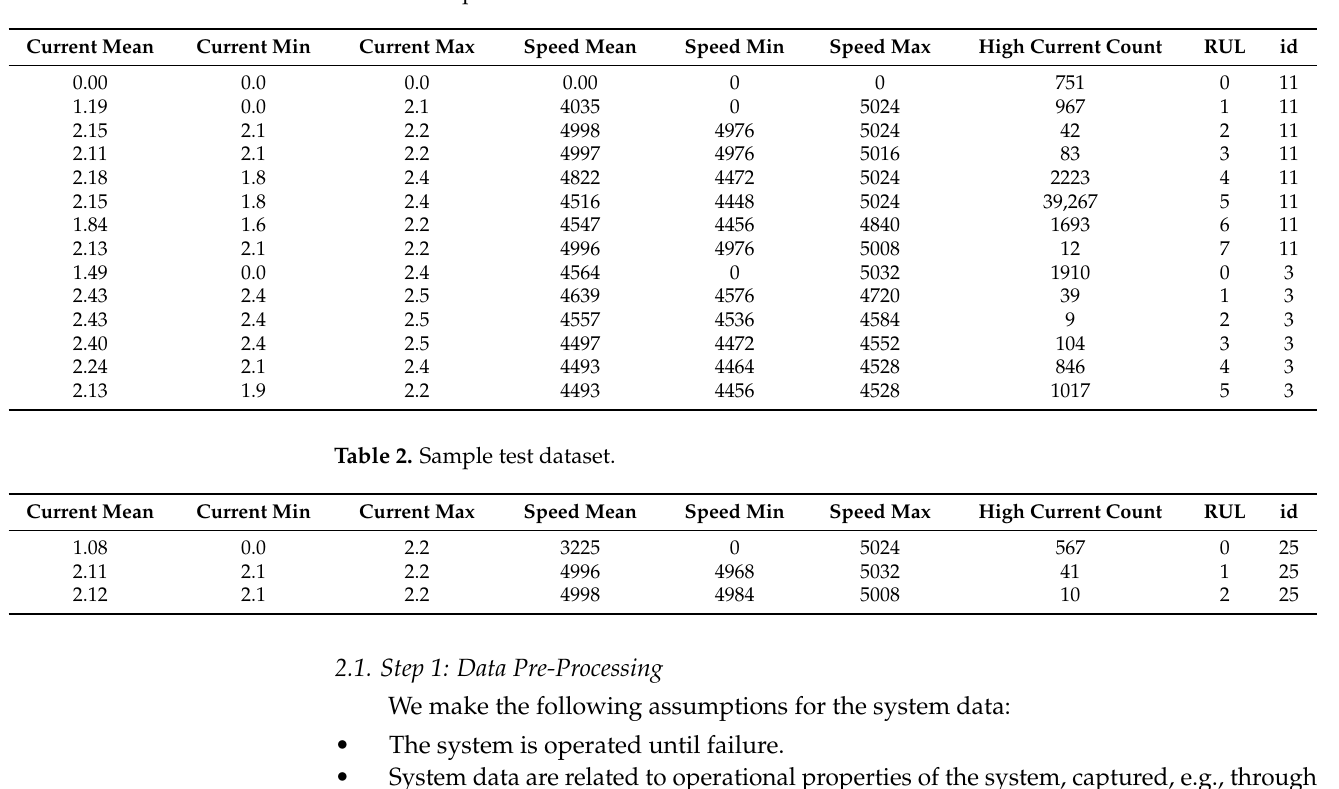
Table 1. Sample train dataset.